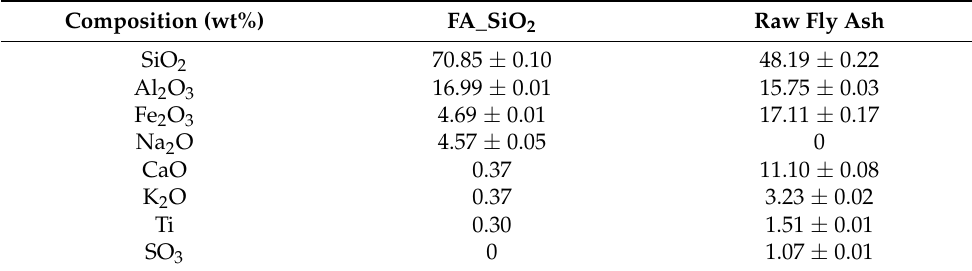
Figure 1. XRD patterns of raw fly ash and FA_SiO 2 . Table 1. XRF analysis of raw fly ash and FA_SiO 2 synthesize in this